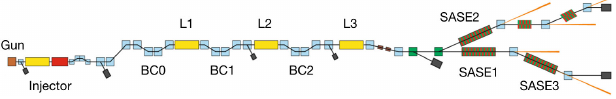
FIG. 11. Schematic layout of the European XFEL (not to scale). The elements shown include 1.3 GHz (yellow) and 3.9 GHz (red) rf sections, undulators (green/red), main dipole magnets (blue), beam distribution systems (green), and beam dumps (black). The main accelerating sections (L1, L2, L3) contain 4, 12 and 84 eight-cavity cryomodules, respectively.